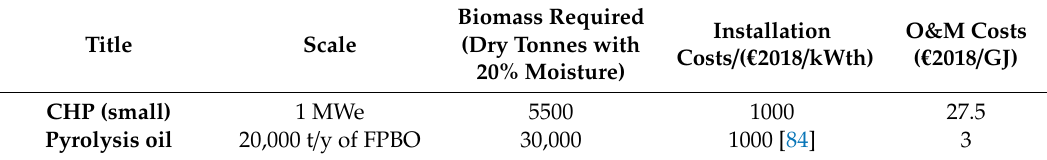
Table 5. Techno-economic assumptions for modelling the understudy value chains.